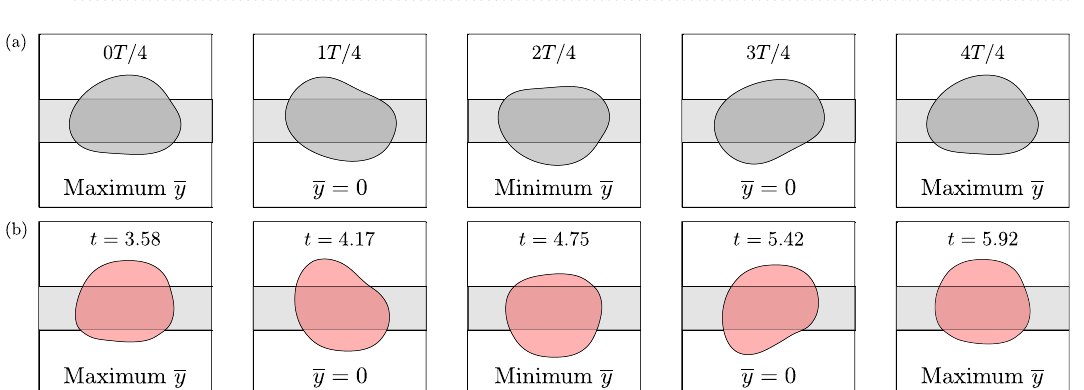
Figure 4. ( a ) Simulated time-sequence of the UPO dynamics for a bubble of size r = 0.54 at dimensionless flow rate Q = 0.032 in the depth-averaged model. The bubble is shown at equally-spaced time intervals of t = T / 4 , where T is the computed period of the UPO. ( b ) Experimental time-sequence of the transient oscillations that were observed experimentally. The data is taken from the red-coloured bubble in Fig.